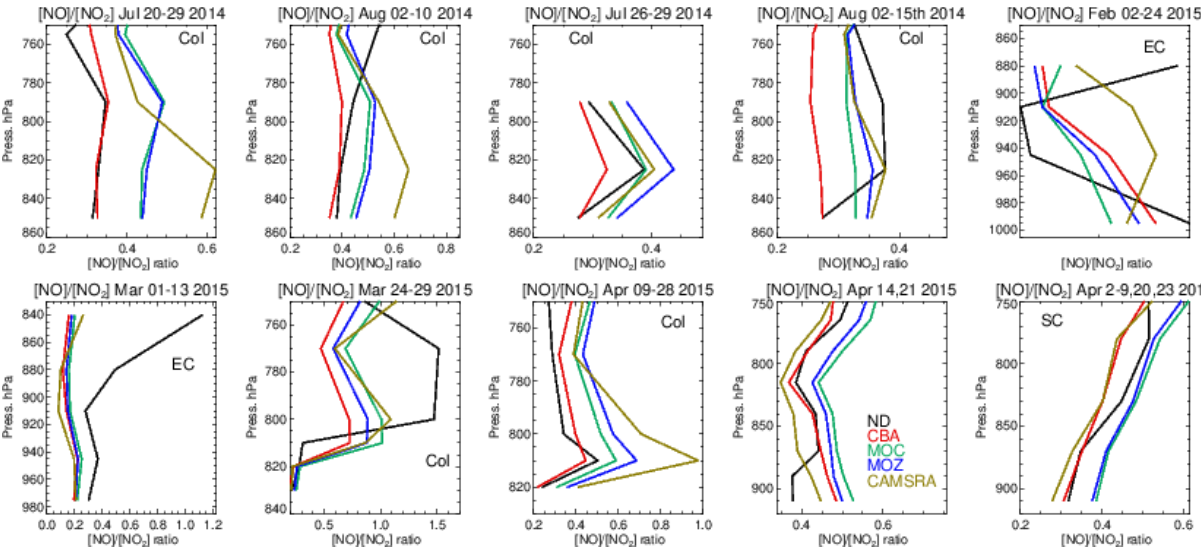
Figure 15. Comparisons of the [ NO ] / [ NO 2 ] ratio for the lower troposphere from the various aircraft campaigns, with observational values shown in black. Campaigns shown (top left to bottom right) are DISCOVER-AQ, FRAPPE, WINTER and SONGNEX.